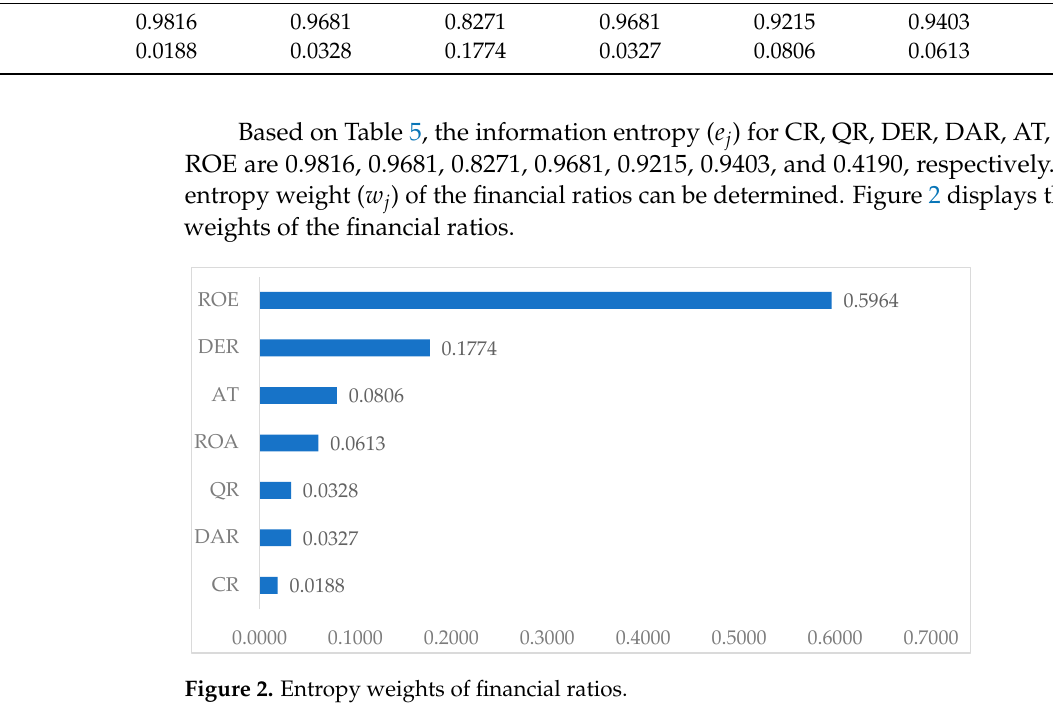
Table 5. The information entropy ( 𝑒 (cid:3037) ) and the entropy weight ( 𝑤 (cid:3037) ) of the financial ratios